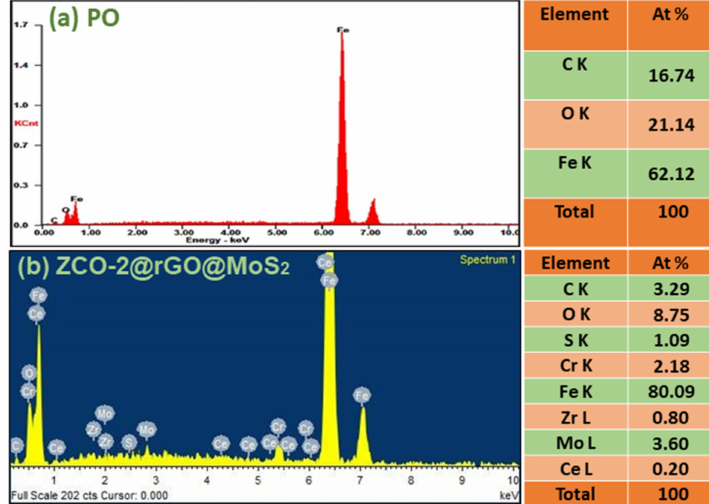
Figure 10. Energy dispersive X-ray (EDX) spectra of worn surface lubricated with ( a ) blank para ffi n oil (PO) and ( b ) PO blended with 0.125% w / v ZCO-2@rGO@MoS 2 nanohybrid at 392 N applied